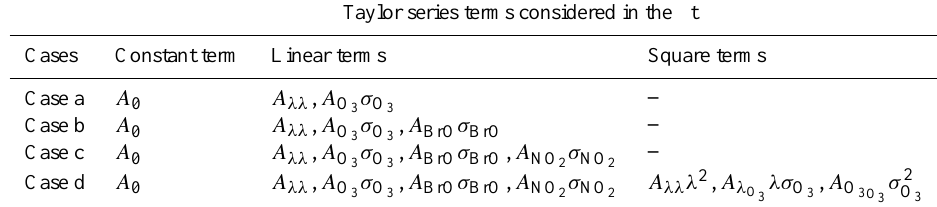
Table A1. Terms of Taylor series expansion considered in the AMF fit study. Taylor series terms considered in the fit